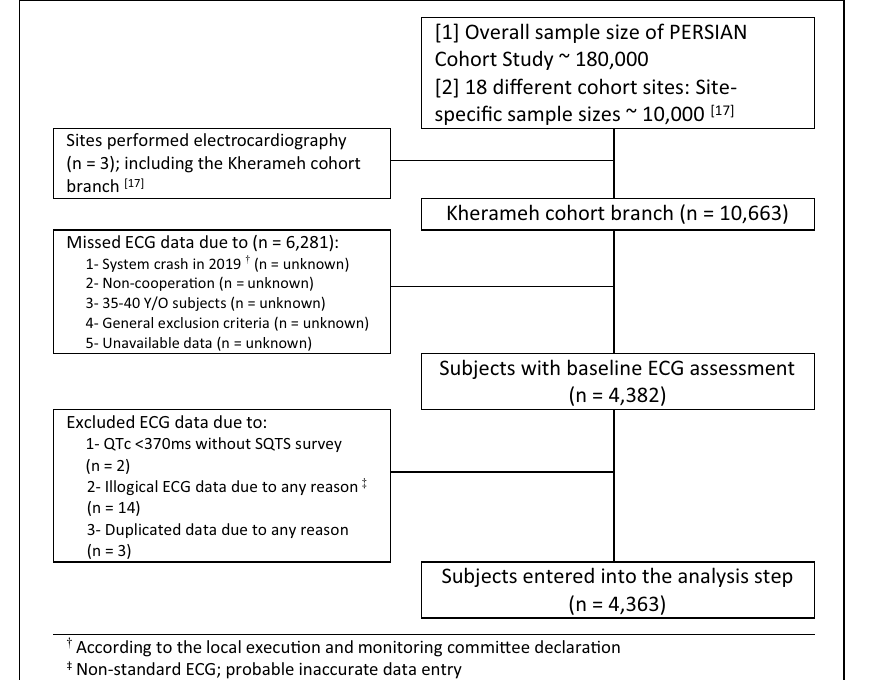
Figure 1. Flowchart of the included subjects from phase I of Kherameh cohort